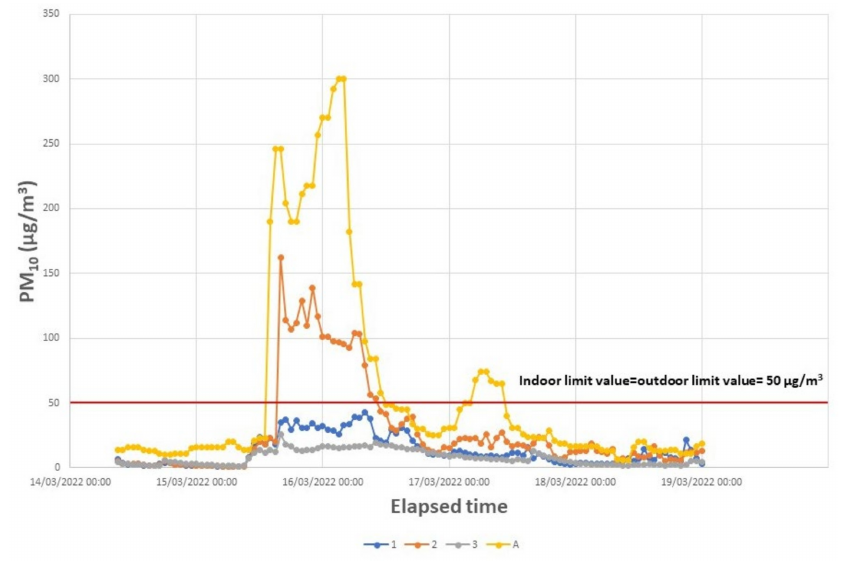
Figure 5. Indoor PM 10 concentrations measured in three buildings (1, 2, and 3), and station A (outdoor) from 14 to 19 March 2022. Outdoor limit value according to European legislation [15] and indoor limit value according to Portuguese legislation [27].